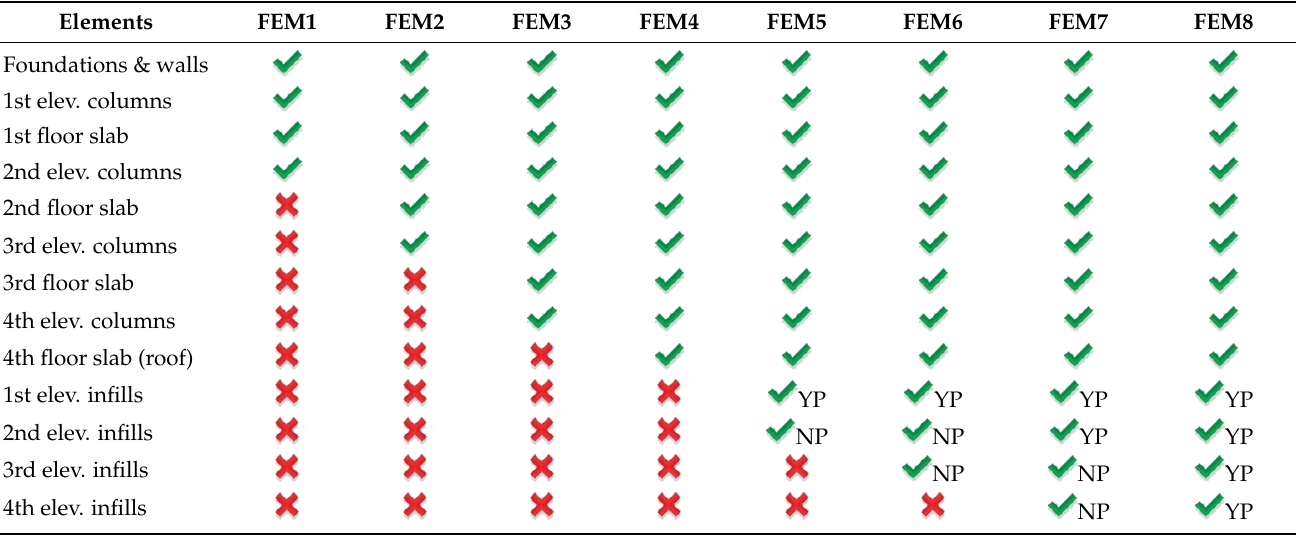
Table 4. Dynamic stiffness in [kN/m] for springs adopted to simulate the soil − structure